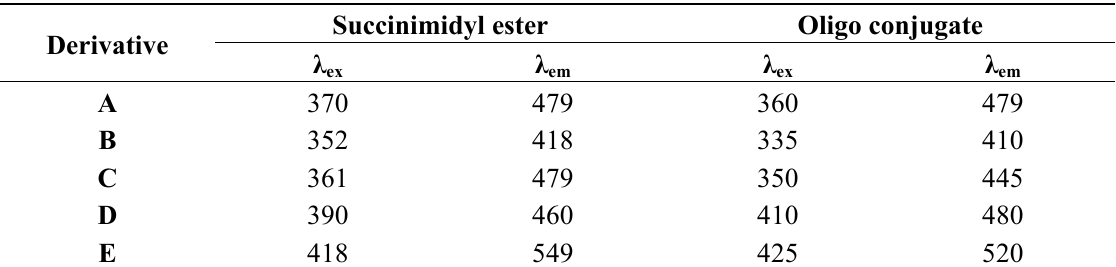
Table 1. List of absorption and emission frequencies of oligothiophene N-scuccinimidyl esters and the corresponding oligonucleotide derivatives.